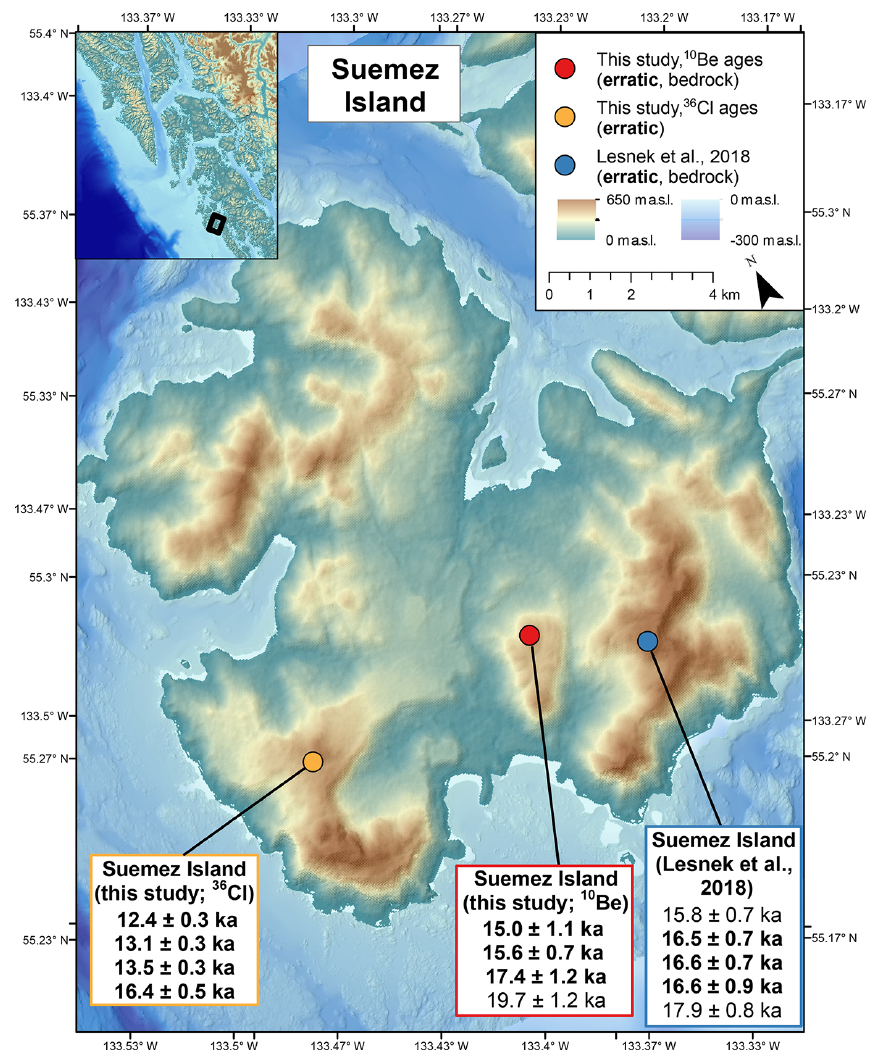
Figure 6. 10 Be and 36 Cl ages from samples collected on Suemez Island: red and yellow dots mark sampling site from this study, blue dot marks sampling site from Lesnek et al. (2018). Bold ages are from boulders; plain ages are from bedrock. All 10 Be and 36 Cl ages reported with 1 σ internal